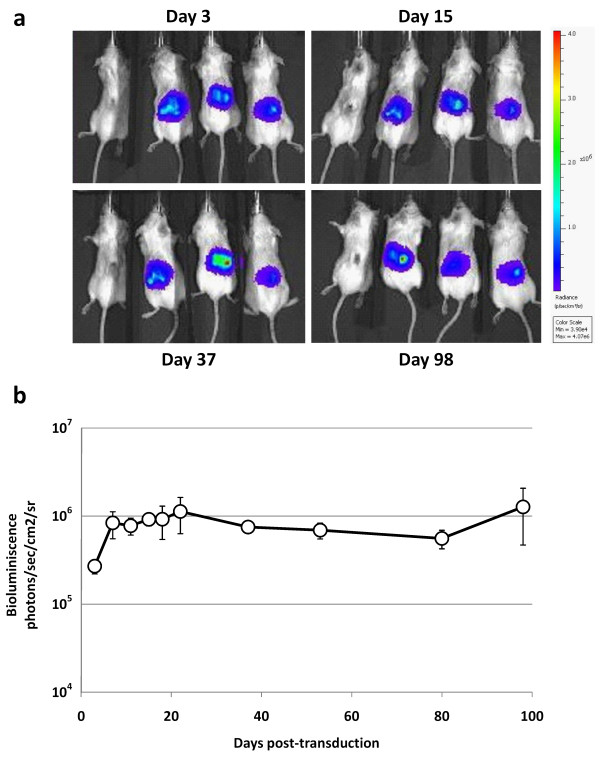
Efficient and persistent transgene expression after lentiviral transduction of xenografted human skin. Normal human skin grafts were xenografted onto the back of four SCID mice and three mice were injected a single intradermal dose of firefly luciferase-encoding lentiviral vectors (three mice to the right in each picture). (a) Representative images of the four mice showing high bioluminescence at day 3, 15, 37, and 98 from the xenografted human skin transduced with luciferase-encoding lentiviral vectors. (b) Bioluminescence from the xenografted human skin on the three mice injected with luciferase-encoding lentiviral vectors was measured at various time points after transduction. Data are depicted as mean ± SEM.